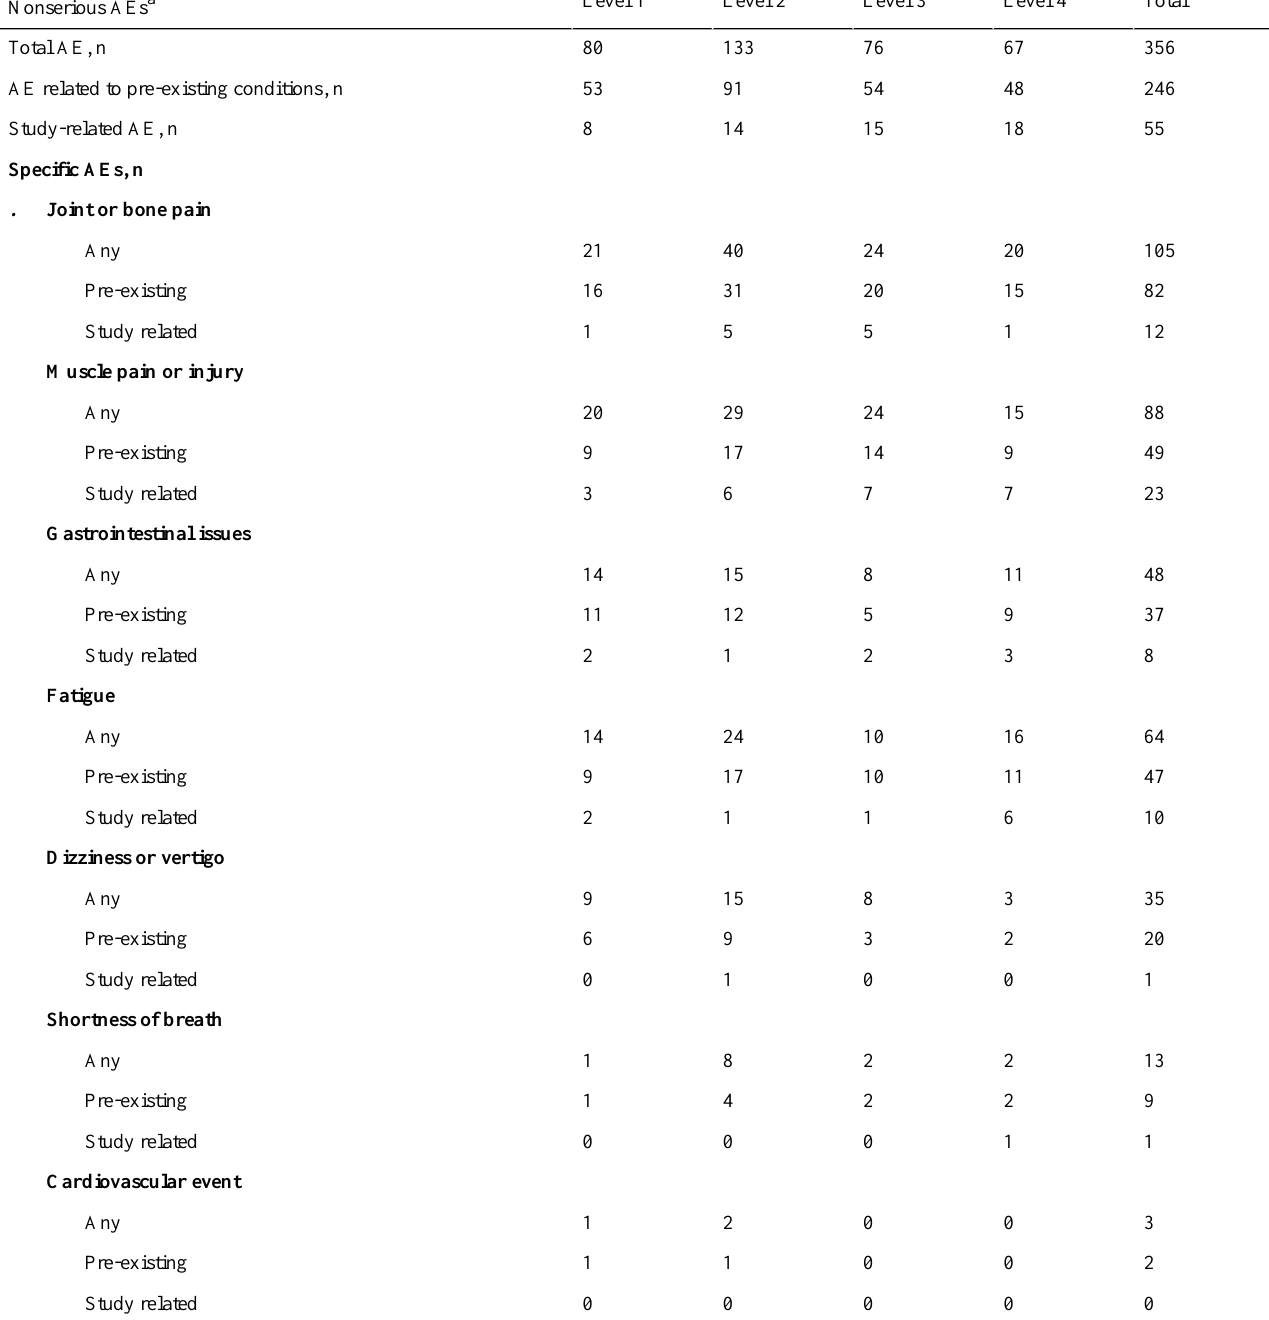
Table 4. Nonserious adverse events self-reported at 3 months among men with prostate cancer participating in a technology-supported behavioral intervention by randomized